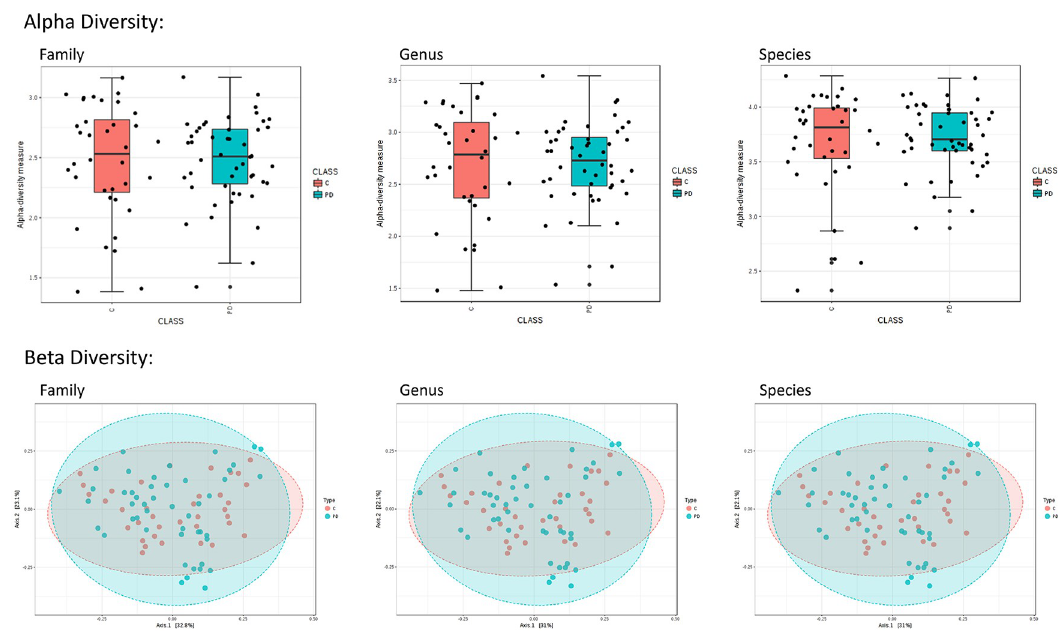
Fig 1. No differences in family, genus or species biodiversity measures in early stage PD. Whisker box plots indicate mean and range of Shannon alpha diversity (upper) and Bray-Curtis dissimilarity measures (lower) for the family, genus, and species levels of